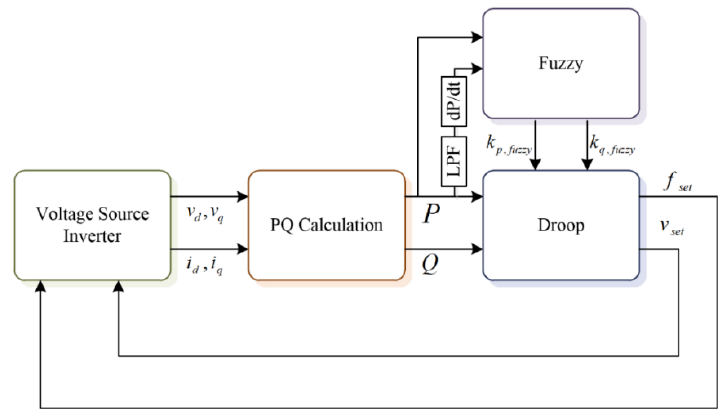
Figure 11. Fuzzy droop controller for operation of voltage source inverter.